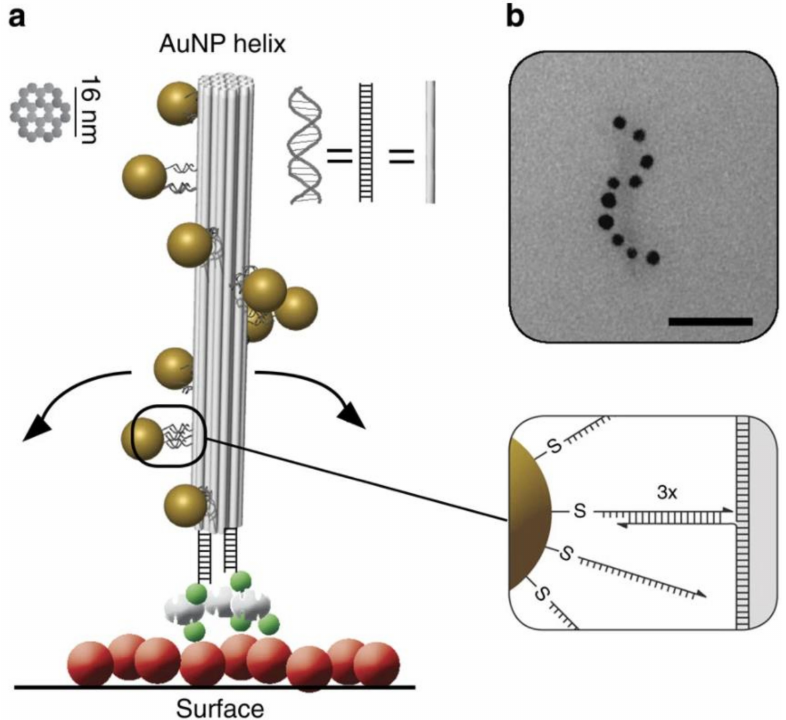
Figure 41. ( a ) A rigid DNA origami bundle composed of 24 parallel double helices. Gold nanoparti- cles are arranged in a secondary left-handed helix on the DNA origami structure. Zoom in: 10nm gold nanoparticle functionalized with thiolated ssDNA hybridized to the DNA origami 24HB. The origami structure is functionalized with biotin groups (green) on one end for the attachment to a BSA–biotin–neutravidin-coated surface (red, green and grey). ( b ) Transmission electron microscopy image of a nanohelix adsorbed non-specifically to a carbon-coated grid. Scale bar, 50nm. Reprinted with reference authorisation [256], Copyright 2013, Macmillan Publishers